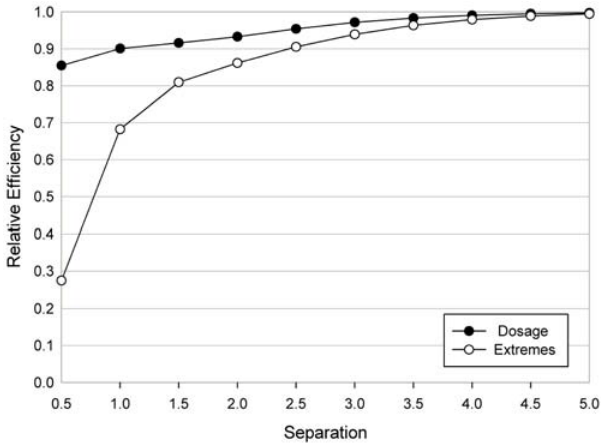
Figure 2. Here we present the relative efficiency Eff (defined in Methods) of the chi-square test of independence in relation to ) between the four the LRTS as a function of separation ( 1 ffiffi g p component distributions that comprise the mixture distribution. All information regarding parameter specification for the Dosage and Extremes models for which relative efficiencies are calculated is presented in the Methods section (Genetic model parameters for efficiency analysis). doi:10.1371/journal.pone.0003475.g002 PLoS ONE |